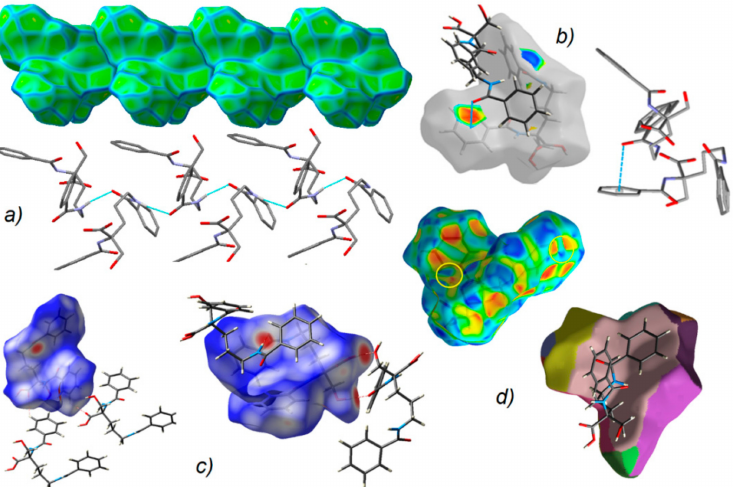
Figure 7. ( a ) Supramolecular chain showed in the context of HS packing; ( b ) view of Hirshfeld surface of 1 mapped over the shape-index property highlighting C = O ... π by blue line and π ... π contacts showed by yellow circles; ( c ) O-H ... O, N-H ... O and C-H ... O H-bonds on the HS over d norm ; ( d ) neighborhood in the relation of fragment patch property.